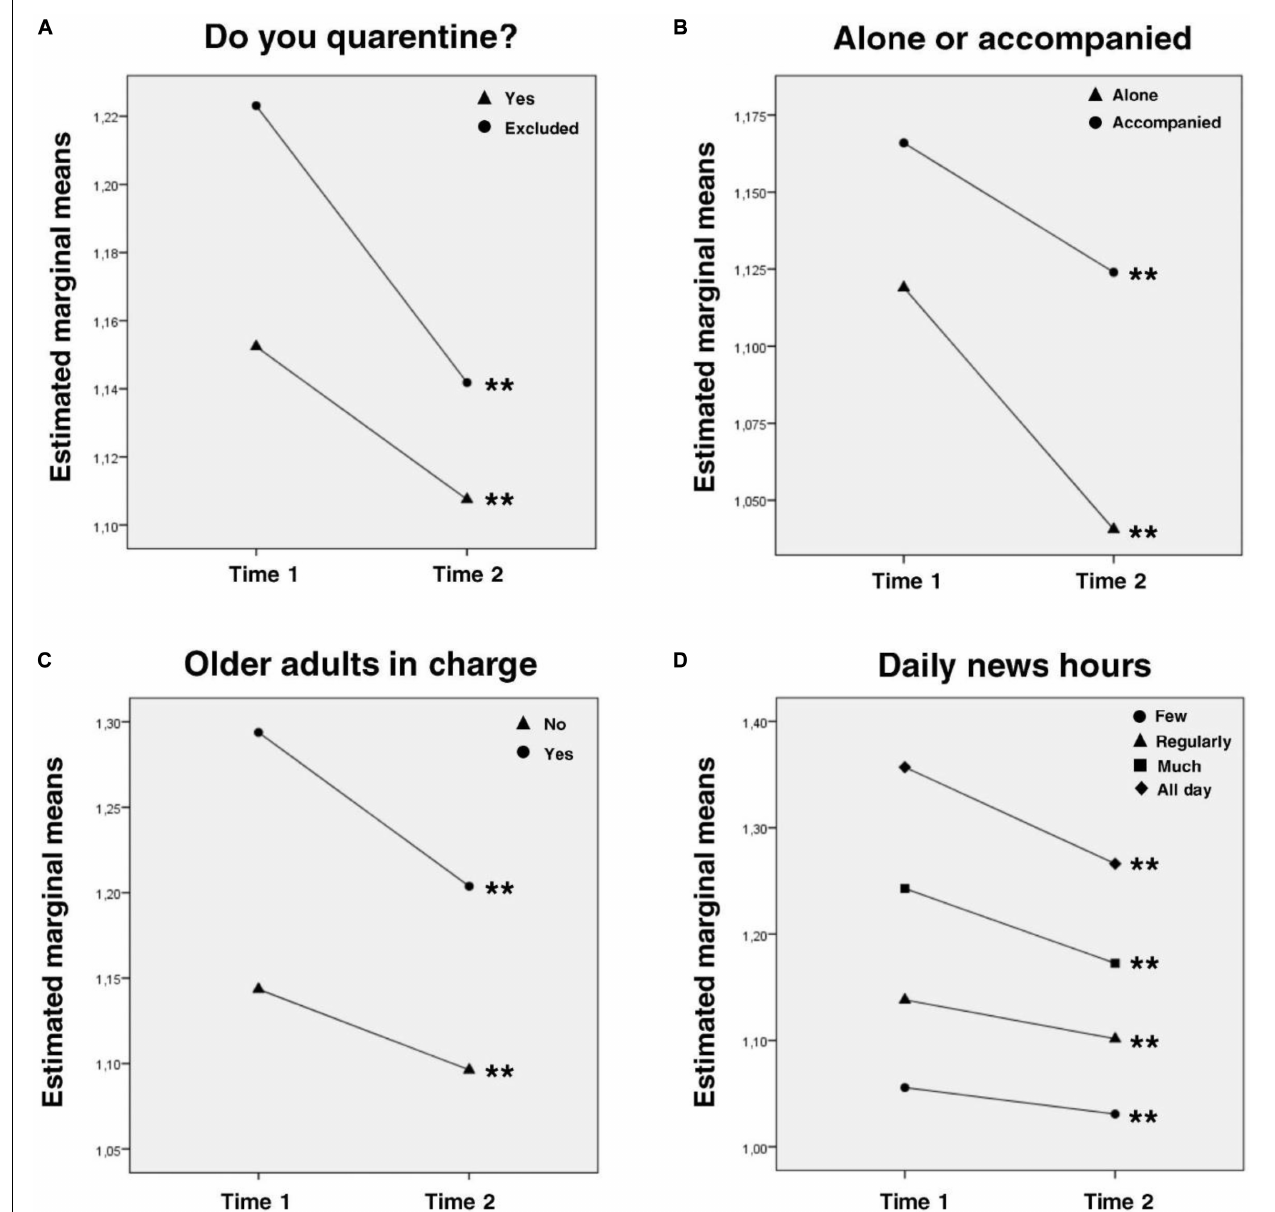
FIGURE 1 | Interaction effects for anxiety levels. Intragroup analysis with Bonferroni correction are expressed in the graphs: line-group with ∗ showed p < 0.05 intragroup differences between time 1 and time 2; line-group with ∗∗ showed p < 0.01 intragroup differences between time 1 and time 2. Post hoc intergroup comparisons with Bonferroni correction (only significant differences are considered, all the comparisons missing were not statistically significant; ∗ p < 0.05, ∗∗ p < 0.01): (A) Time 1: Yes, Excluded ∗∗ . (B) All the intergroup comparisons were statistically significant ∗∗ . (C) All the intergroup comparisons were statistically significant ∗∗ . (D) All the intergroup comparisons were statistically significant ∗∗